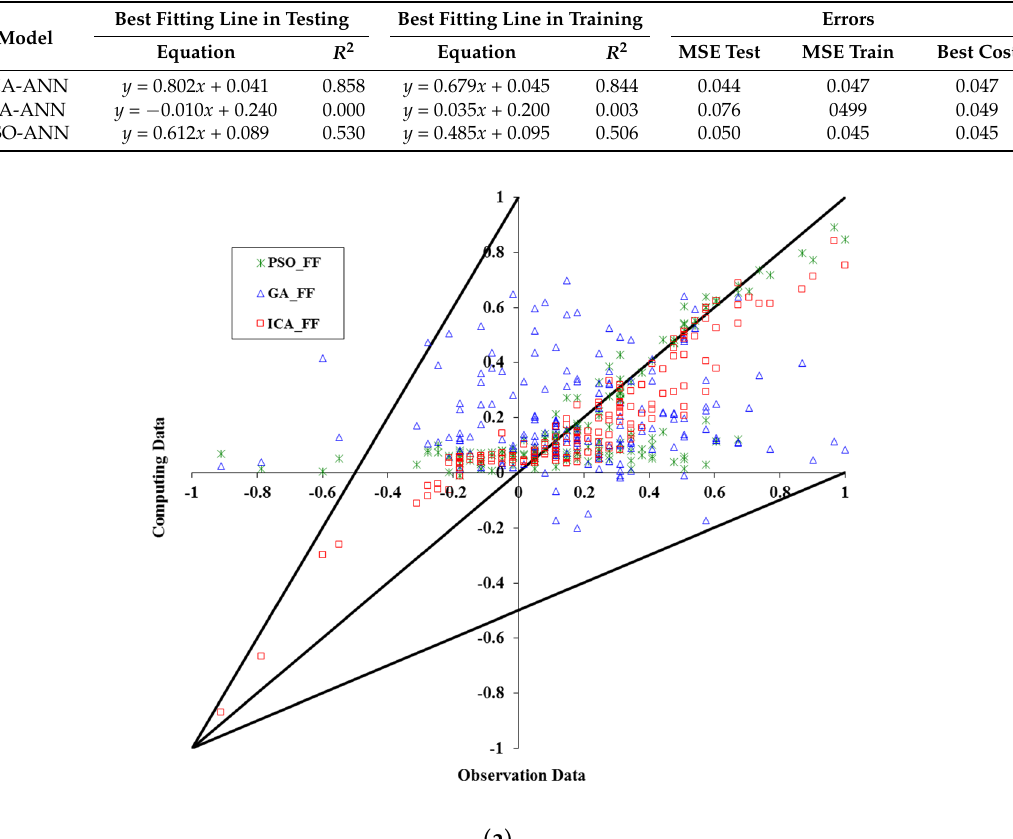
Figure 6. Cont. Figure 6.